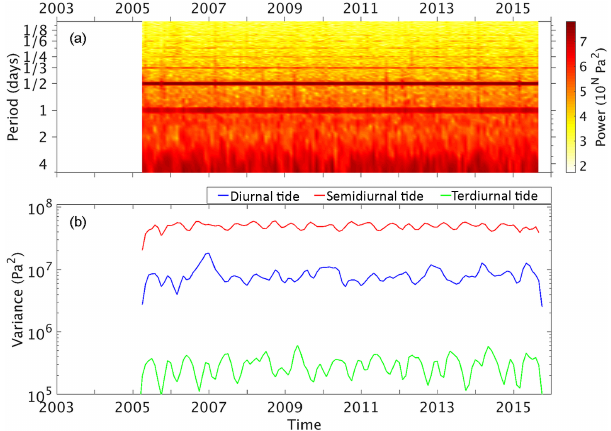
Figure 10. Colour-coded PSD spectrum (a) of the monthly air pres- sure fluctuations at IS21 as function of time and Fourier period, and the variances of the diurnal, semi-diurnal, and terdiurnal tide (b) .